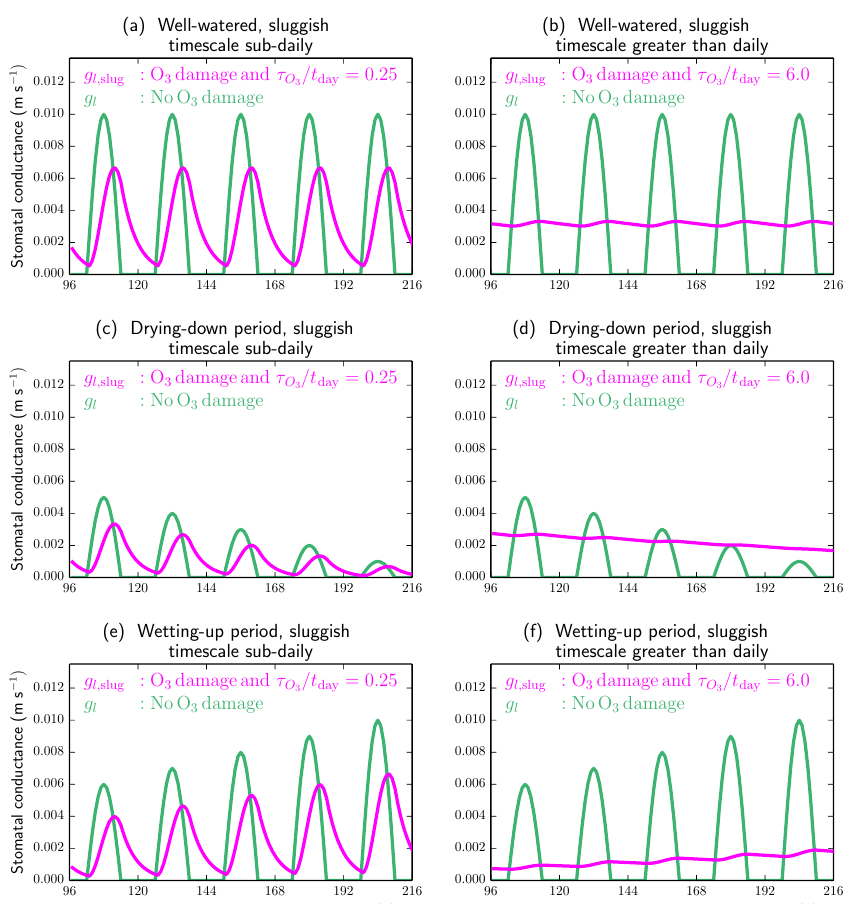
Figure 1. The effect of low (a, c, e) and high (b, d, f) levels of stomatal sluggishness. Calculations for stomatal conductance correspond to well-watered conditions (a, b) , entering a period of drought (c, d) and recovery from drought (e, f) . Simulations are for nine 24h periods, with the last five shown. Green curves are stomatal conductance without ozone effects, and magenta curves are with sluggishness. Appendix A details the modelling framework and driving conditions leading to these